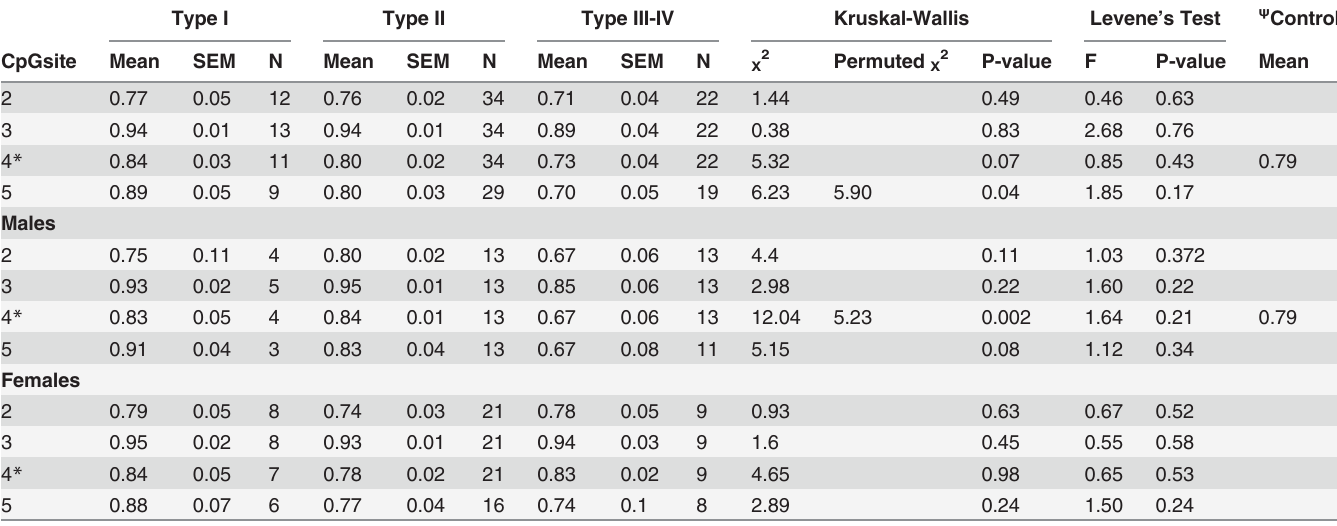
Table 4. Methylation levels (%) of CpG sites in the analyzed region of 5 ’ UTR of NCOR2